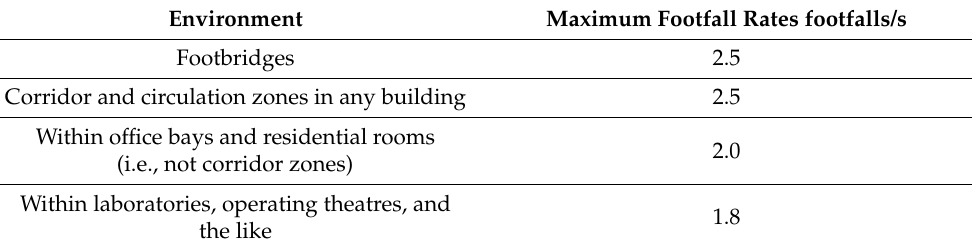
Table A4. The maximum footfall rates related to different environments according to